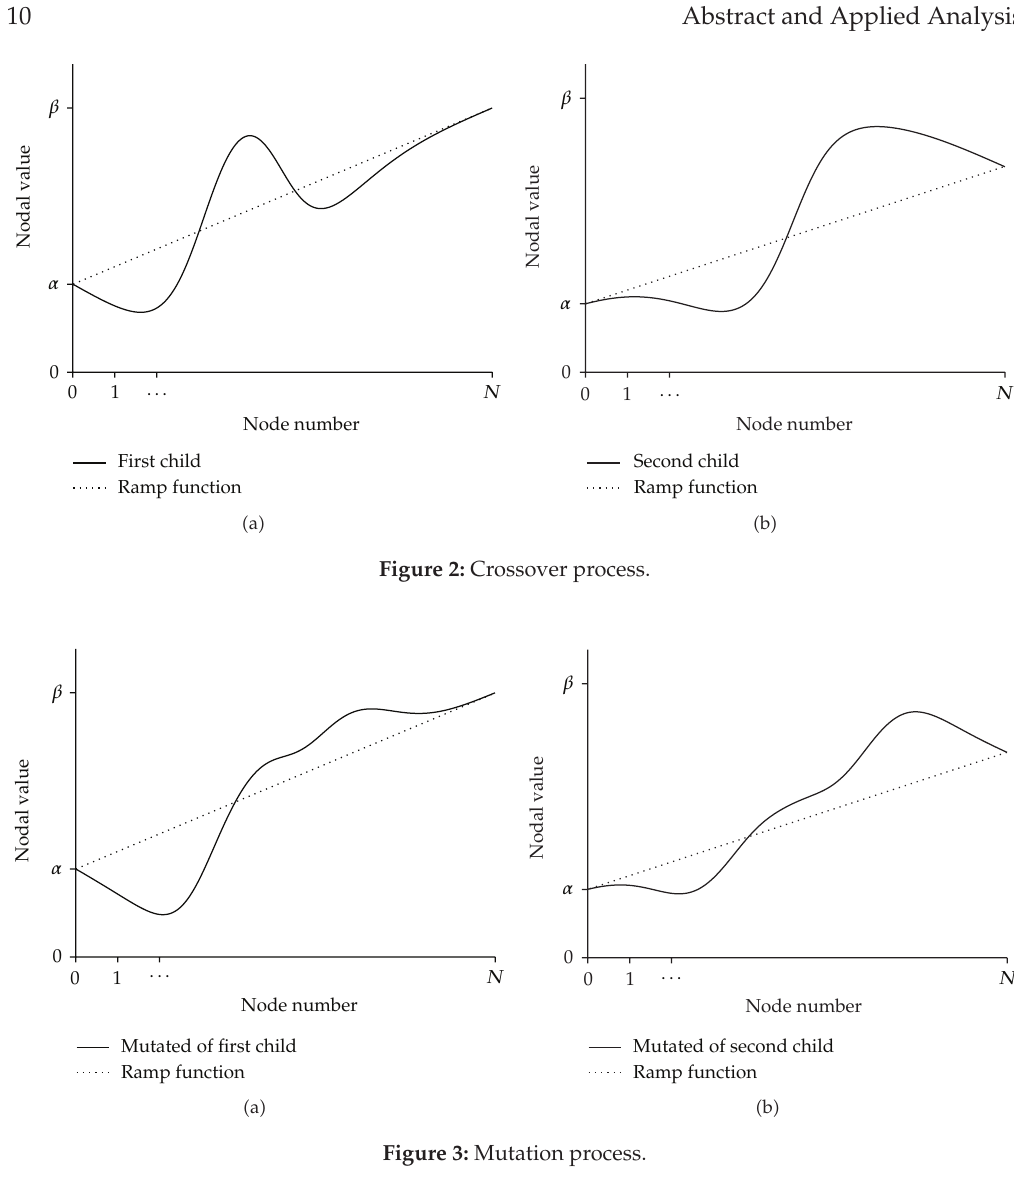
Figure 3: Mutation